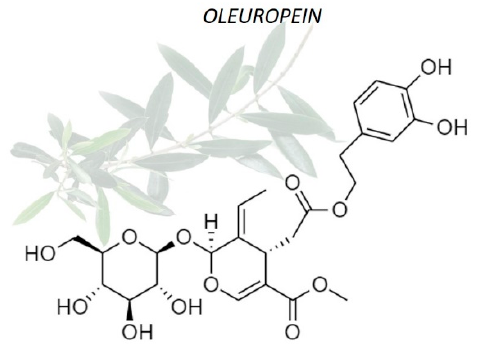
Figure 1. Chemical structure of oleuropein. The o -dihydroxy (catechol) groups present in its chemical structure confer antioxidant properties of oleuropein.